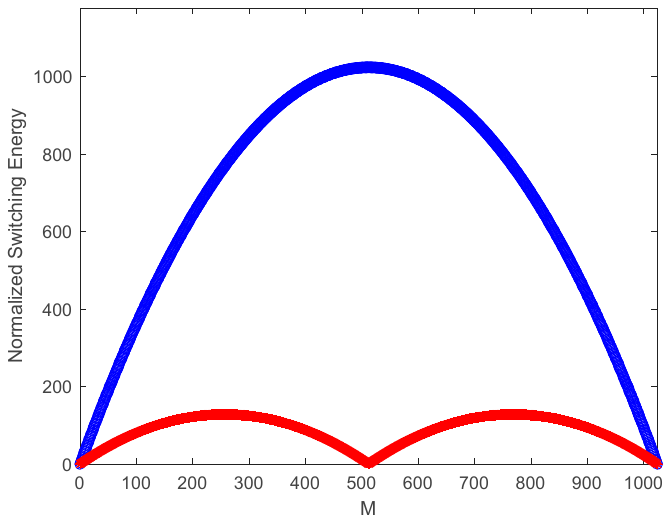
Figure 5. Normalized switching energy of the 2-level (blue) and 3-level (red) switching schemes ( N = 1024).